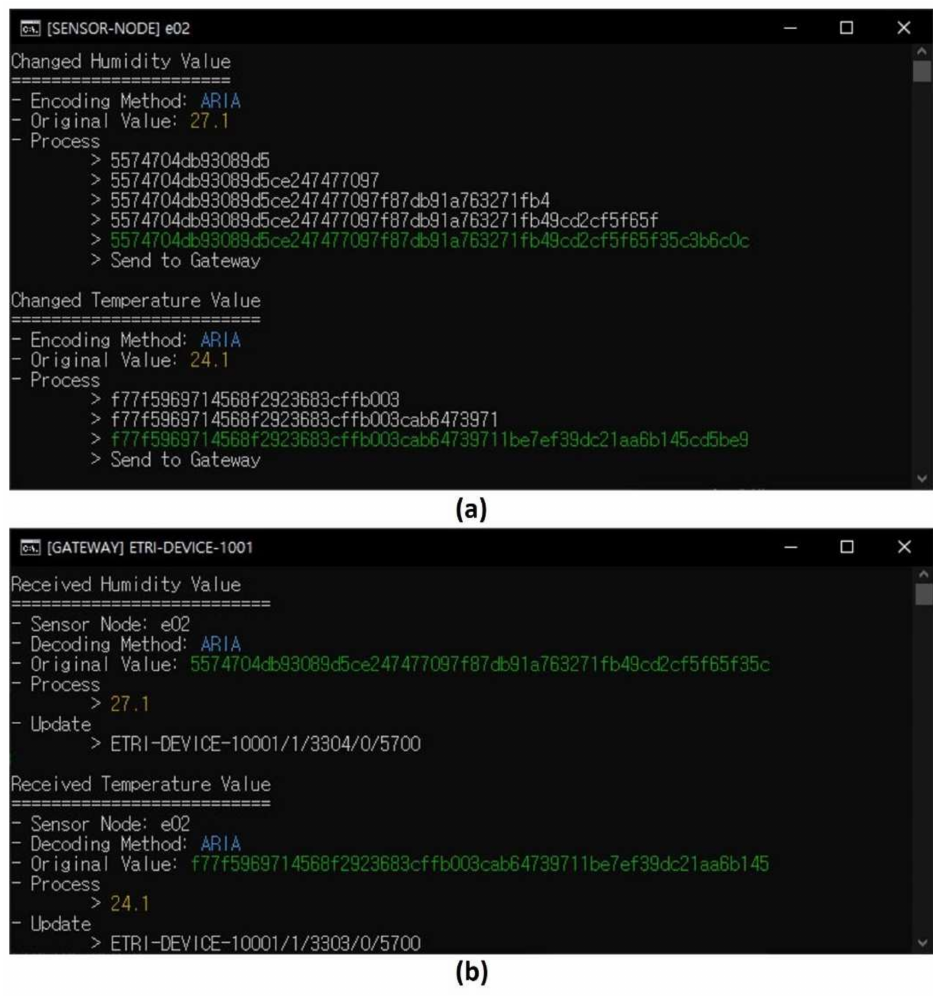
Figure 10. ( a ) Encrypting and transferring data from a sensing device; ( b ) decrypting on a